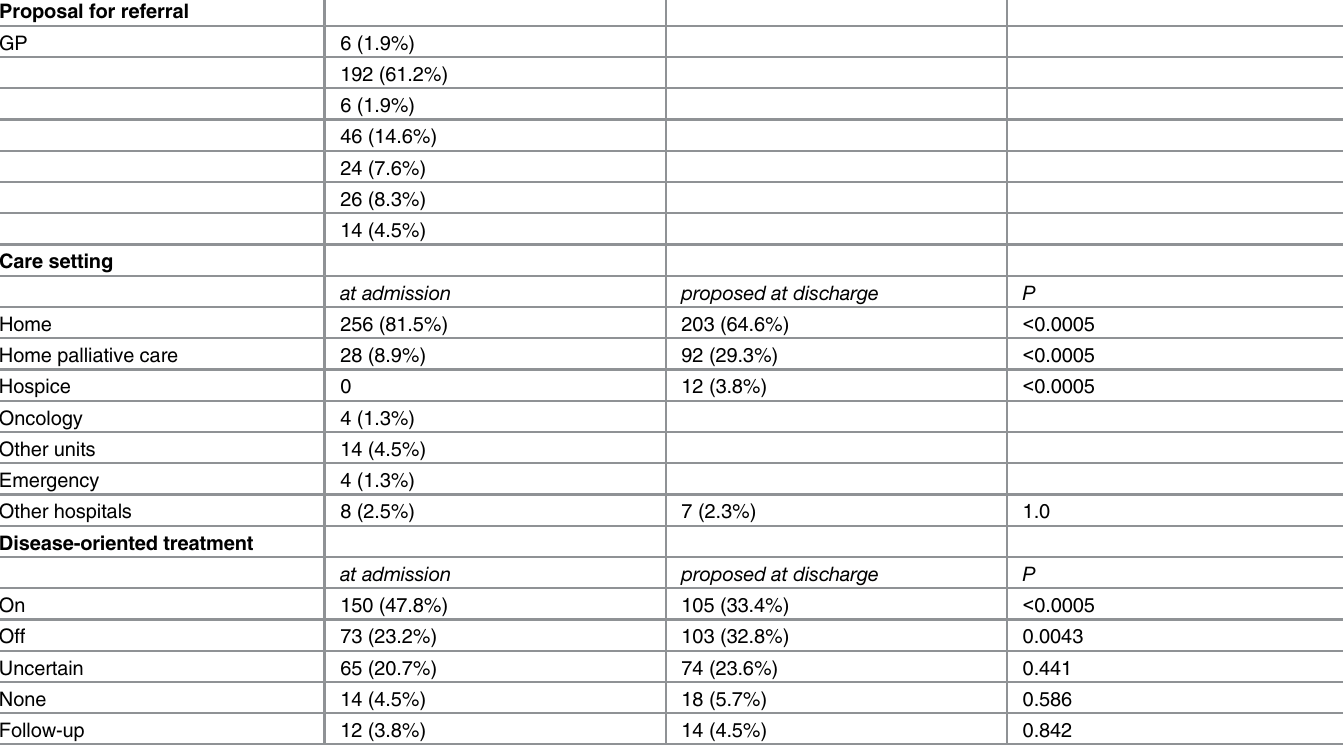
Table 2. Data regarding the previous disease-oriented treatment, the setting where patients were previously cared and who referred the patient at admission, and care setting, physicians to refer patients and clinical pathways suggested at discharge from the unit. APSCU = acute palliative-sup- portive care unit.